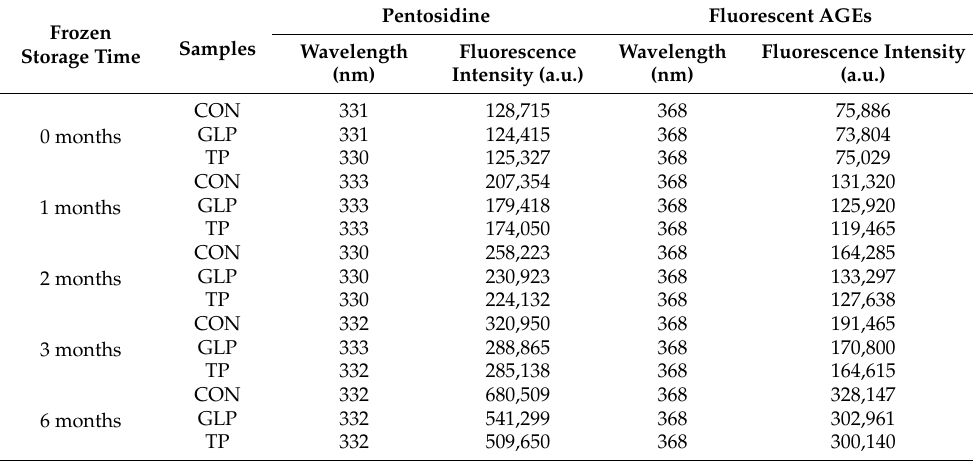
Table 2. Assignments of the maximum peak of the pentosidine, and fluorescent